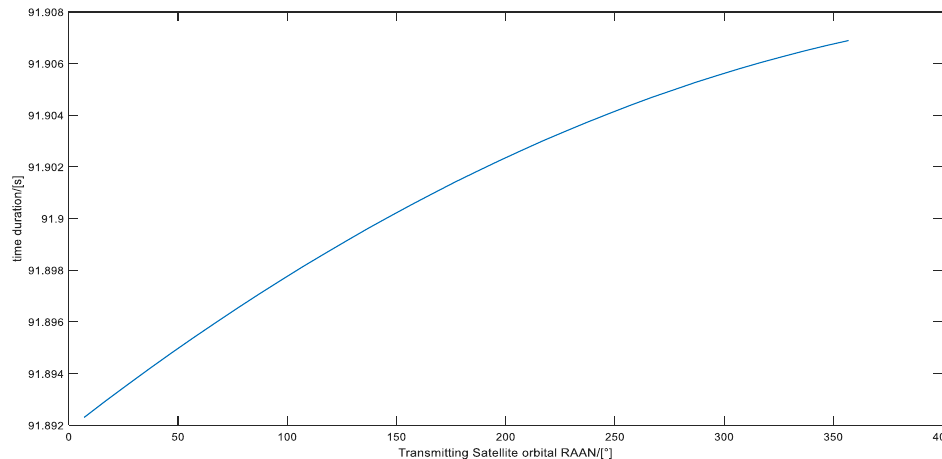
Figure 4. Variation in occultation duration with AP .